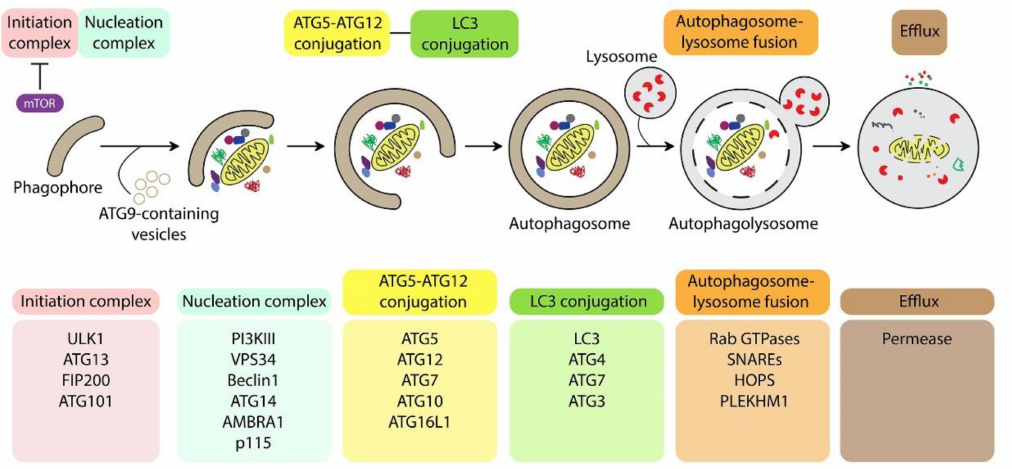
Figure 1. Autophagosome formation, maturation, and degradation require the autophagic core machinery. Autophagy is a multistep process that begins with the nucleation of a double membrane called a phagophore. The ULK1 complex and the nucleation complex ensure autophagy initiation, whereas ATG9 vesicles allow the shuttling of membrane sources. The expansion of autophagoso- mal membranes is dependent upon the two conjugation systems and allows the sequestration of intracytoplasmic material. The degradative properties are acquired after the fusion between au- tophagosome and lysosome. After completion, the degraded material is recycled into the cytoplasm via permeases